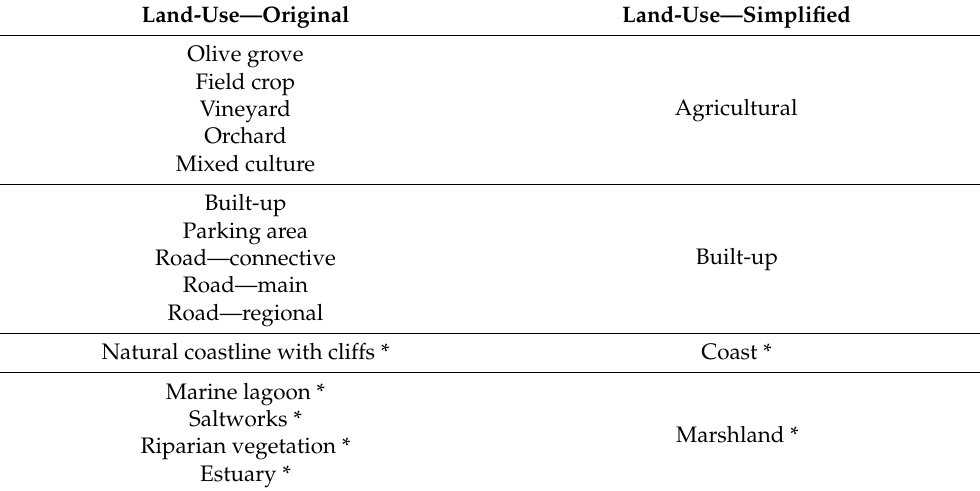
Table 7. Two levels of land-use categories used as explanatory factors for the diversity and occurrence of aliens in the study area. Land-uses considered of higher priority for biodiversity conservation are indicated with asterisk